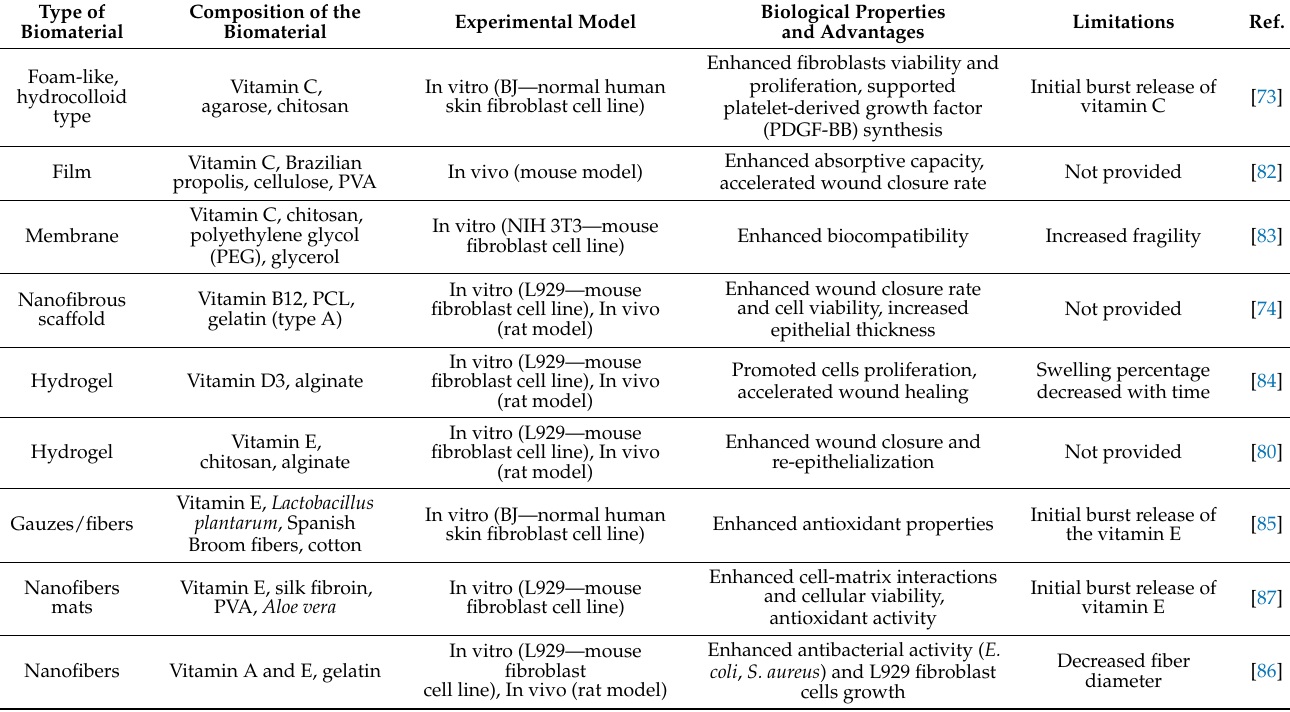
Table 3. Vitamin-enriched biomaterials for wound healing